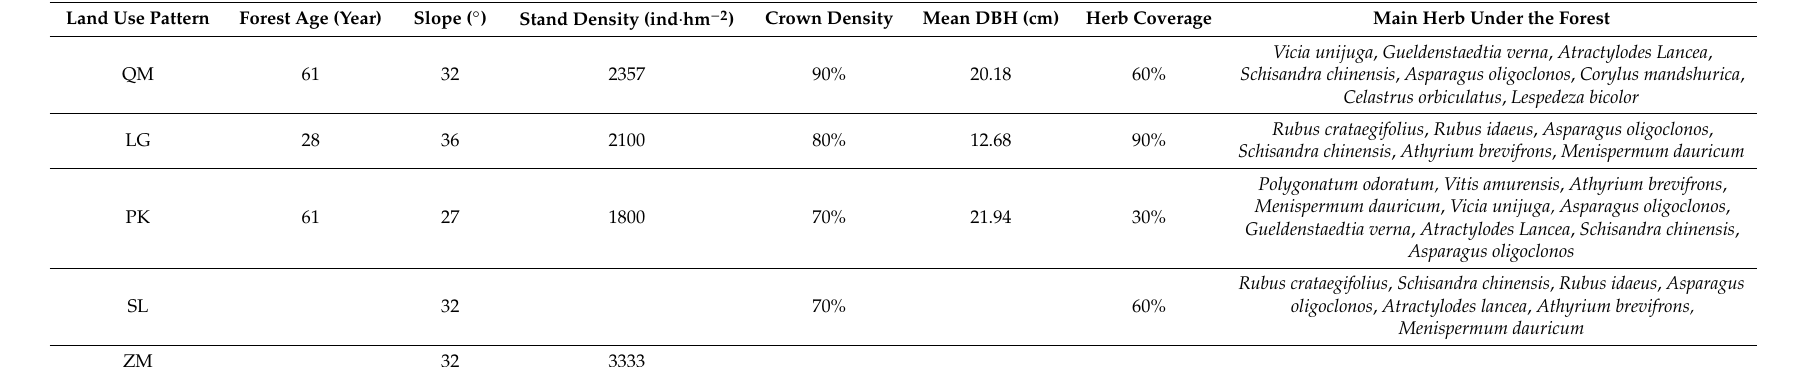
Table 1. Information of di ff erent land use